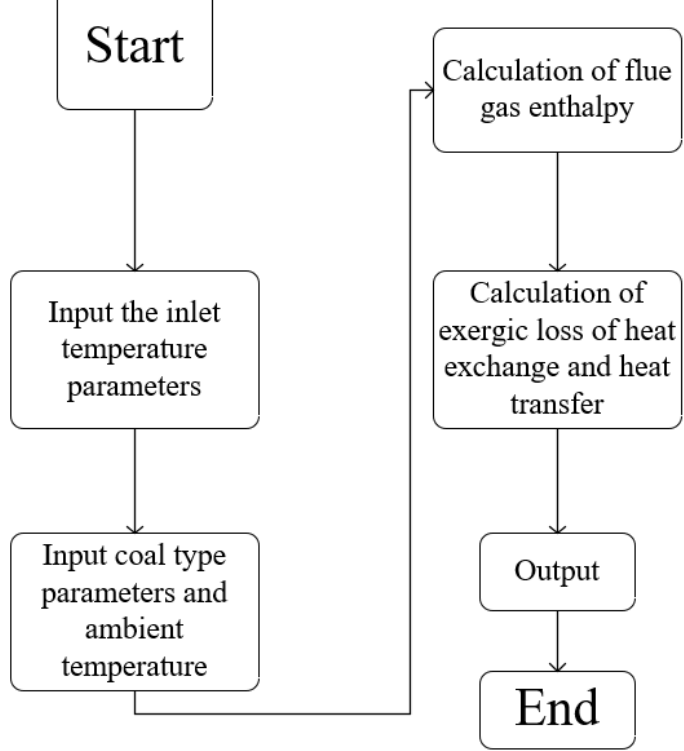
Figure 2. Flow of the program.